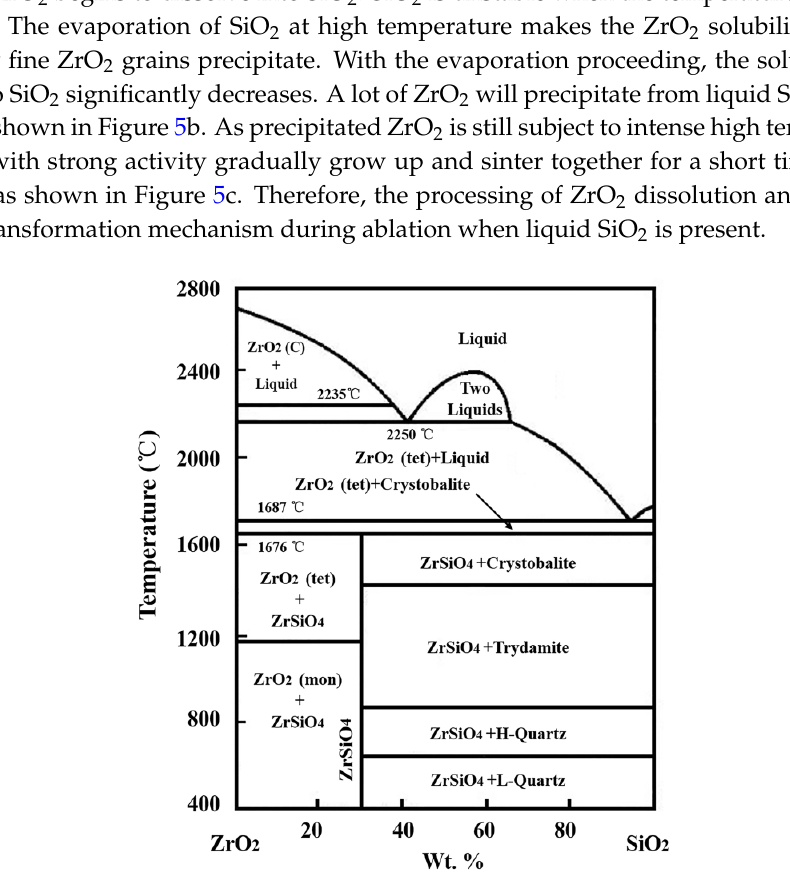
( b ) Figure 7. The morphology of ZrB 2 /SiC at the edge after ablation ( a ) with nano ZrO 2 crystals packing on the surface ( b ). 3. Experimental Section The ZS composite was prepared using commercial powders listed as follows: ZrB 2 (Alfa Aesar Ward Hill, MA, USA, 99.0%, particlesize ~50 μ m); SiC (Alfa Ascar, 99.5%, particlesize 1–2 μ m).The